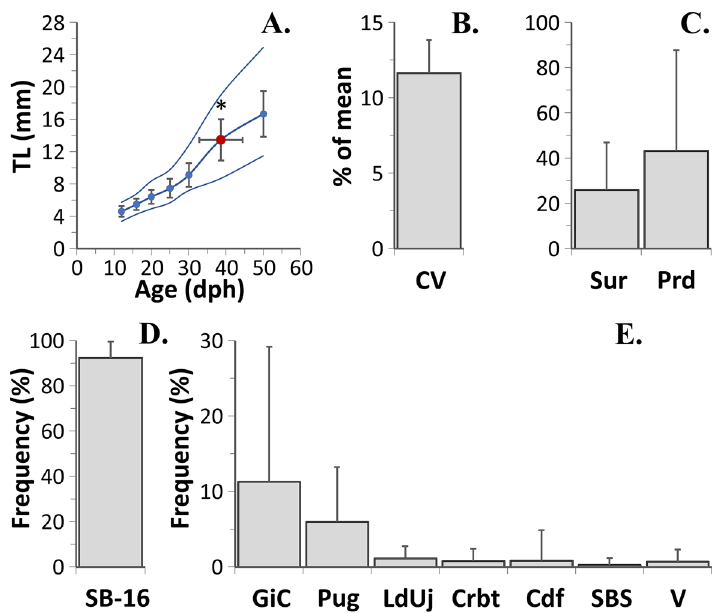
Figure 3. Mean values of the recorded Key-Performance-Indicators in the 74 monitored populations. ( A ) Average fish total length (TL) during the larval rearing and weaning period. Asterisk (*) indicates the mean TL and age of the fish samples which were examined for skeletal abnormalities (quality control). ( B ) Coefficient of variation of fish TL at quality control. ( C ) Average survival rate (Sur, in %) at 26–70 dph. Prd indicates the mean number of fish survived per volume unit (L) of the larval-rearing tank (fish/L). ( D ) Mean frequency of normally inflated swimbladder at 16 dph. ( E ) Mean frequency of skeletal abnormalities. Cdf, caudal-fin abnormalities. Crbt, crossbite. GiC, gill-cover abnormalities. LdUj, lateral displacement of the upper jaw (fused maxillaries and pre-maxillaries). Pug, pugheadedness. SBS, saddleback syndrome. V, vertebral abnormalities. Error bars equal 1 standard deviation. n = 74 samples (of ca 50 specimens each).